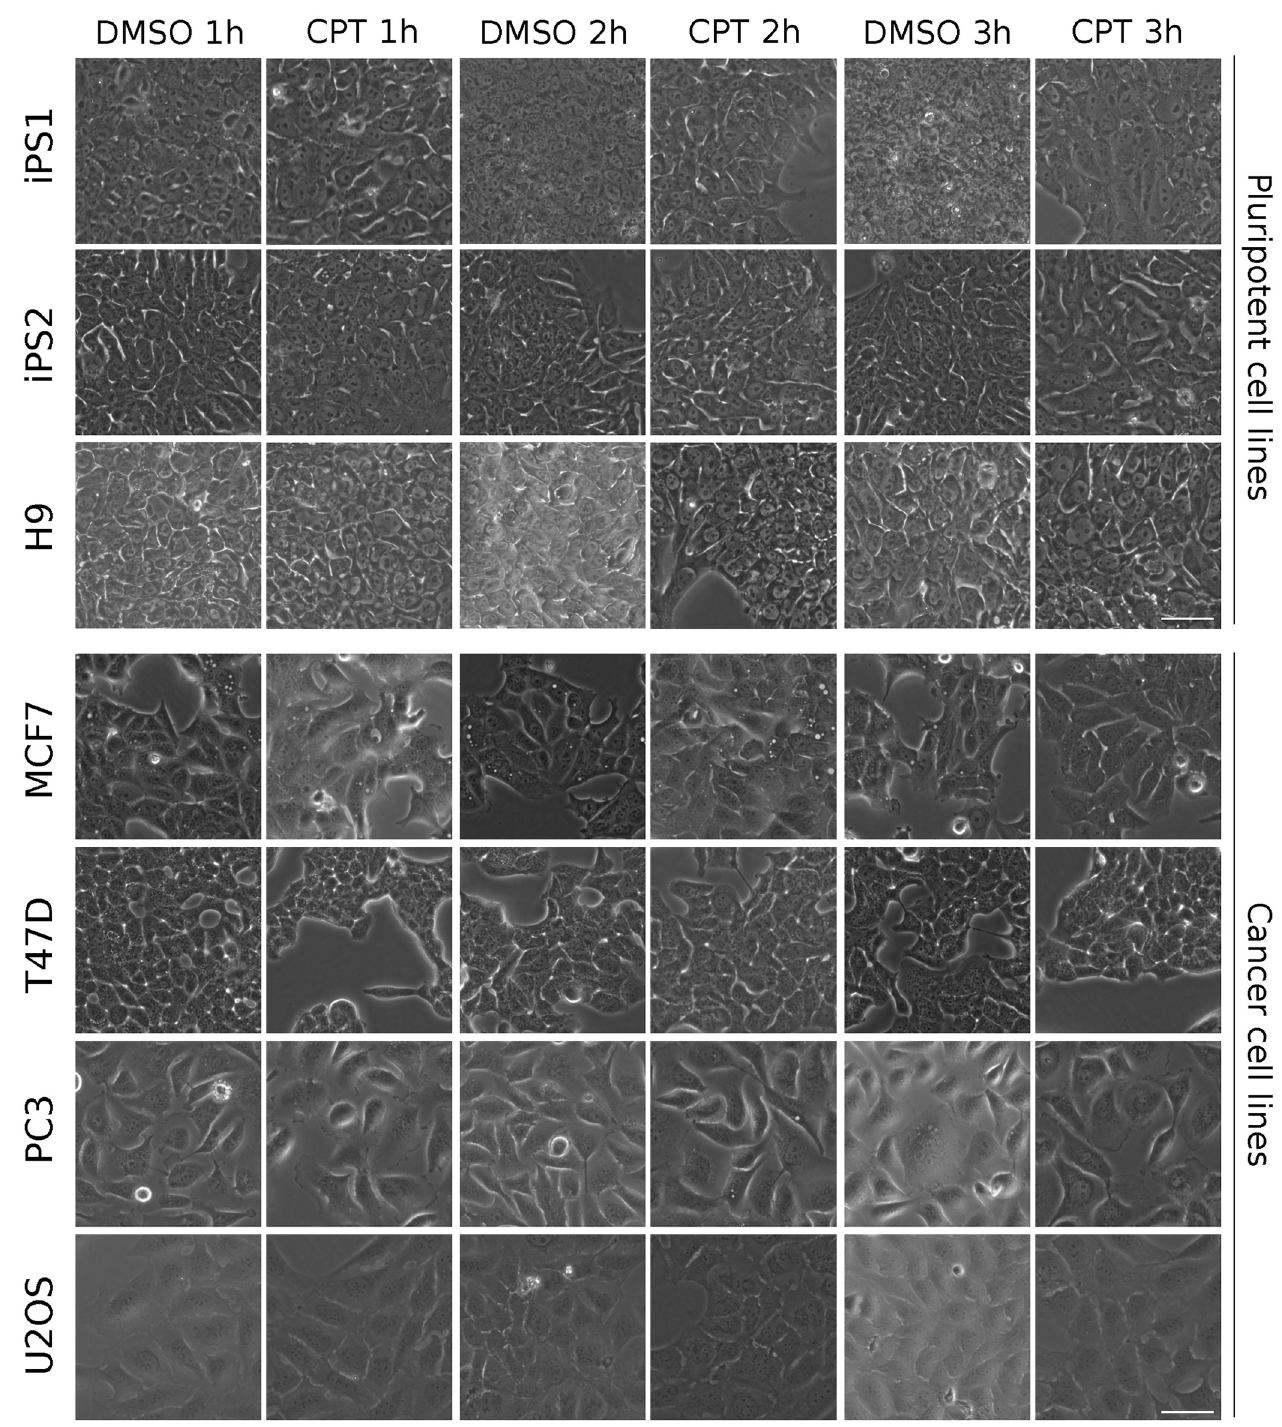
Fig 2. Transmitted light images used for visual deep learning analysis. Representative images of DMSO (vehicle)- and CPT-treated cell lines for 1, 2 and 3h. Scale bar is displayed in the pictures and equals to 50 μ m.